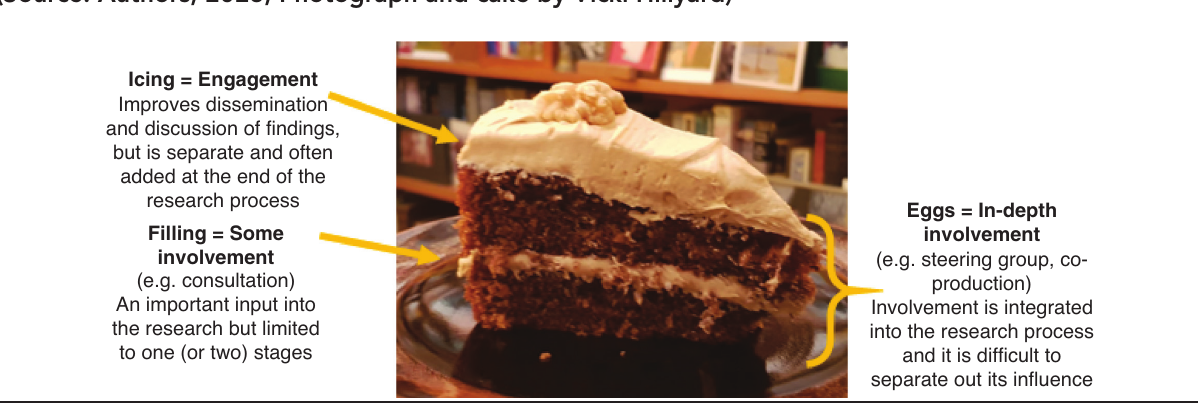
Figure 1. Cake metaphor for engagement and involvement in research, developed by the authors (Source: Authors, 2023; Photograph and cake by Vicki